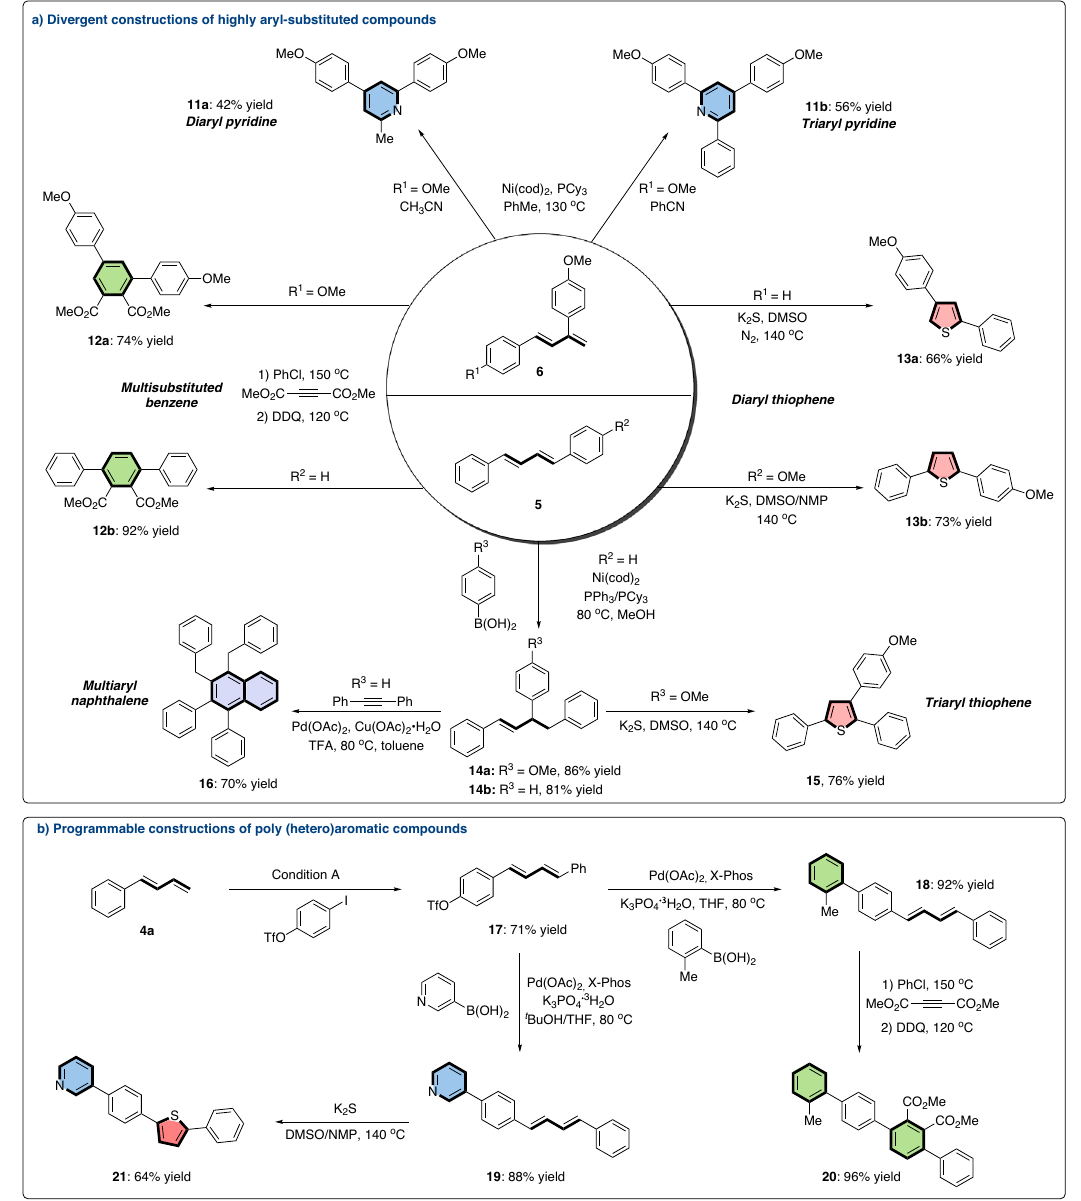
Fig. 3 | Divergent and programmable synthetic transformations of dienes. a Divergent constructions of highly aryl-substituted compounds. b Programmable con- structions of poly (hetero)aromatic